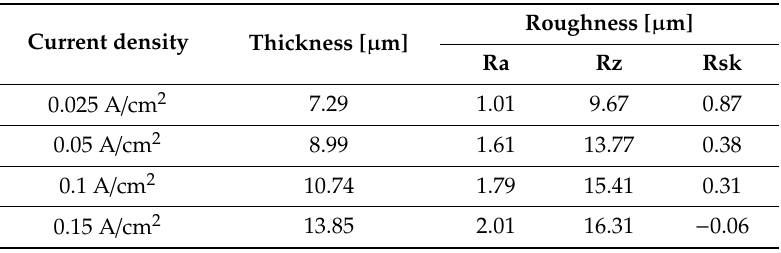
Figure 5. Morphology of the PEO coating prepared in the electrolyte with 12 g / L of Na 3 PO 4 · 12H 2 O and current density of 0.025 A / cm 2 ( a ), 0.05 A / cm 2 ( b ), 0.1 A / cm 2 ( c ) and 0.15 A / cm 2 ( d ). Table 5. Thickness and roughness parameters of the PEO coatings prepared in the electrolyte with 12 g / L of Na 3 PO 4 · 12H 2 O.